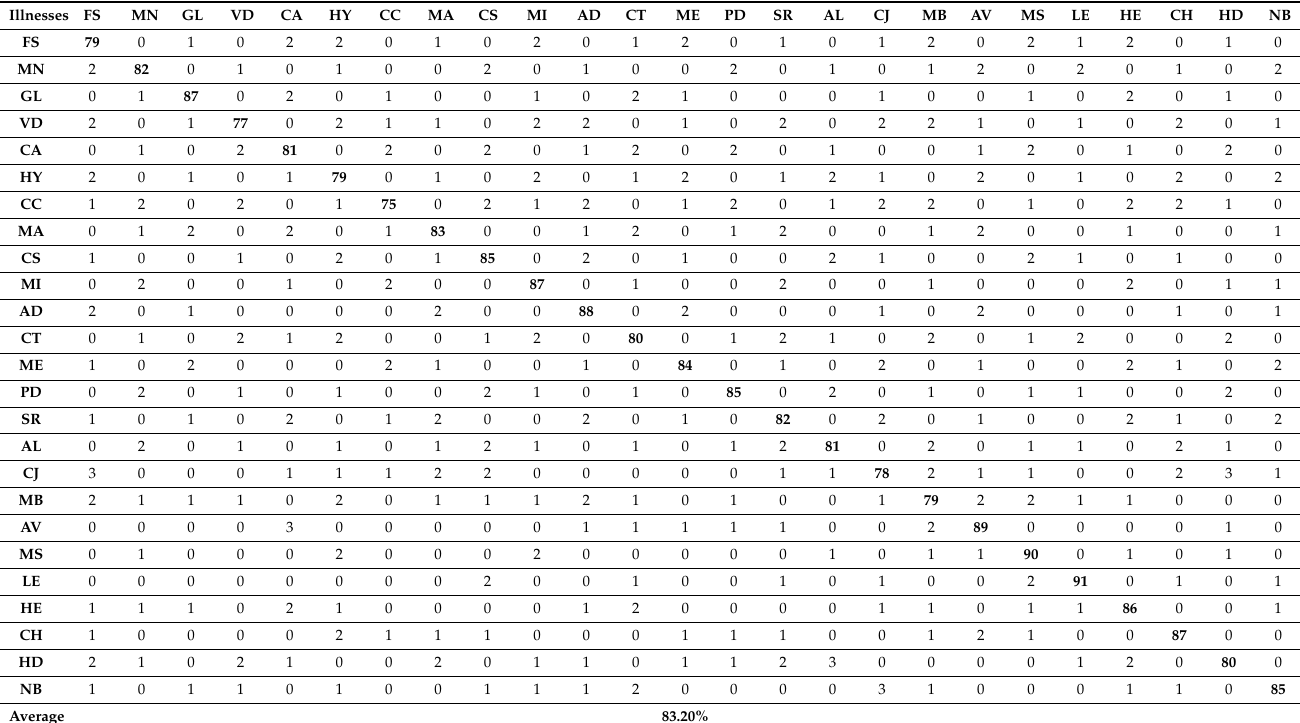
Table 7. Performance of Semidefinite Embedding method (instead of using the developed approach) using MRI dataset (Unit